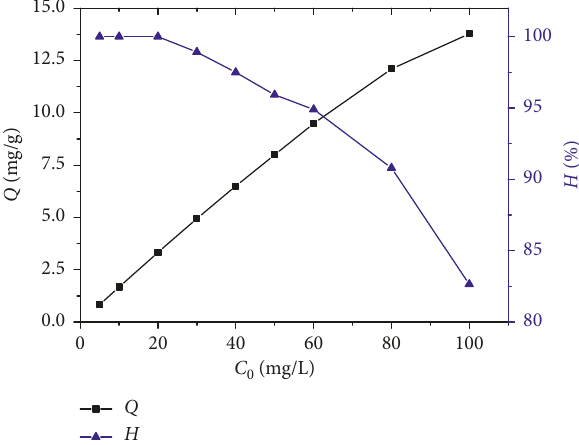
Q Figure 12: The effect of initial Pb 2+ concentration on the ad- sorption capacity and the removal efficiency of Pb 2+ ( m HAp 6g/L; (cid:31) granules (cid:31) 6g/L; pH 0 5.5; t contact (cid:31) 40min; T (cid:31) 30